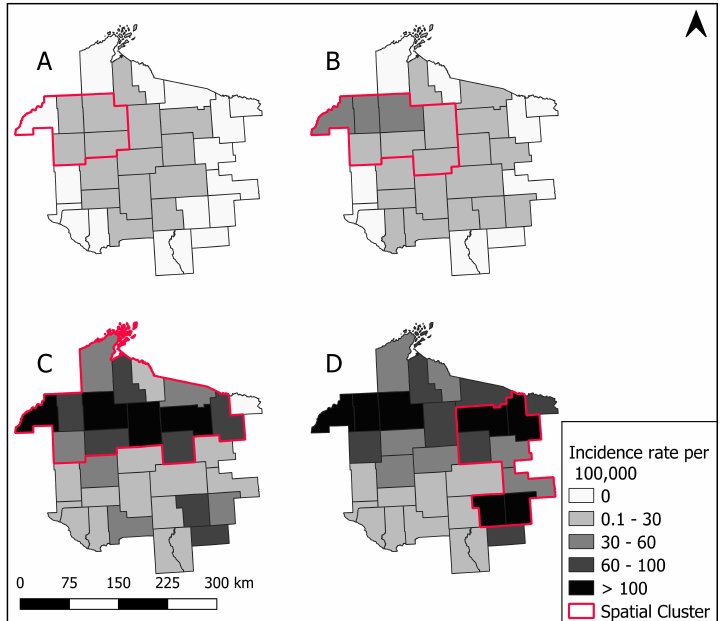
Figure 6. County level incidence of positive laboratory cases of human granulocytic anaplasmosis (HGA) per 100,000 patients from time periods of ( A ) 2000–2003, ( B ) 2004–2007, ( C ) 2008–2011, ( D